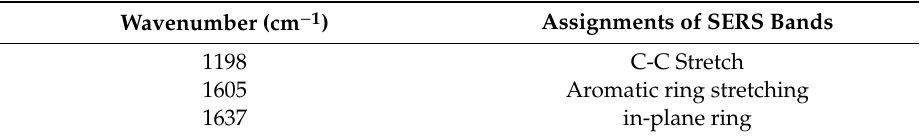
Figure 10. SERS spectra of BPE detected on the AuNRs substrates fabricated at different deposition angle: ( a ) θ = 80°; ( b ) θ = 82°; ( c ) θ = 84°; ( d ) θ = 86°; ( e ) θ = 88°. Table 2. Assignments of SERS bands of BPE.